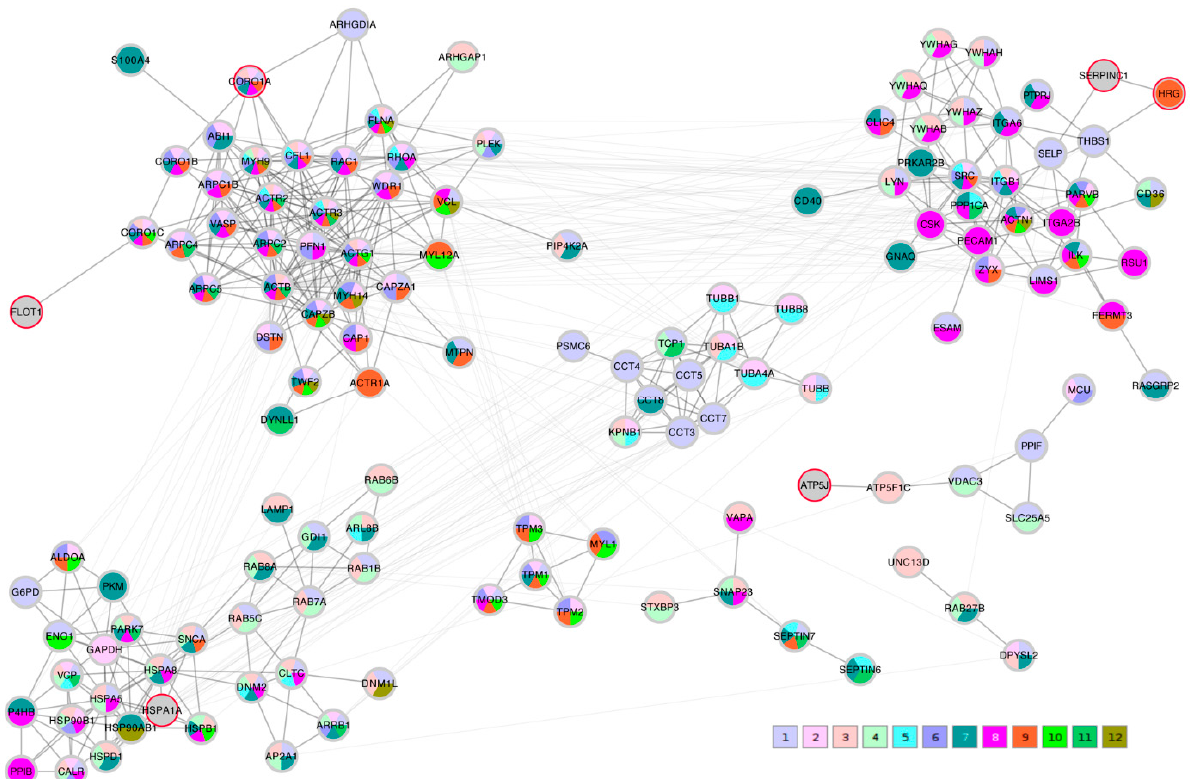
Figure 5. STRING protein-protein interaction network composed of proteins that were significantly correlating with all C transport metrics (C_TK/RMS/VDV) and the Lasso proteins. Edges represent a STRING combined score ≥ 0.7; they are drawn thick within community clusters, and thin across community clusters. The Lasso proteins are marked with a red border (gray otherwise). Node colors at the bottom right refer to GO terms given in Table 4, with 1–6 standing for biological process and 7–12 cellular component.